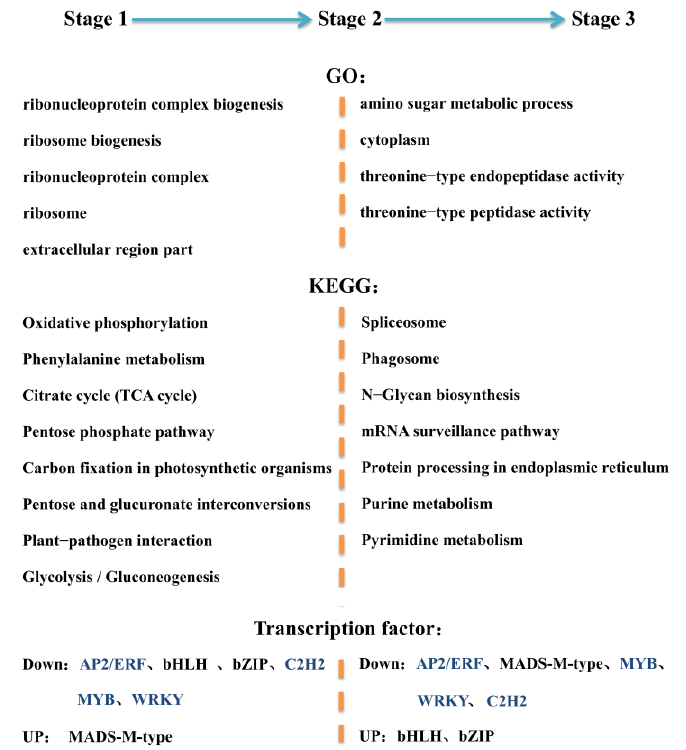
Figure 8. An overview of function and transcription factor family changes involved in celery anther development at the three flower developmental stages (S1, S2, S3). GO and KEGG both show di ff erent functions at di ff erent stages. The transcriptional abundance of transcription factor families with a consistent trend is shown in